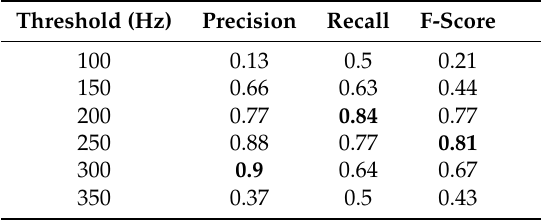
Table 1. Results of the automatic genre